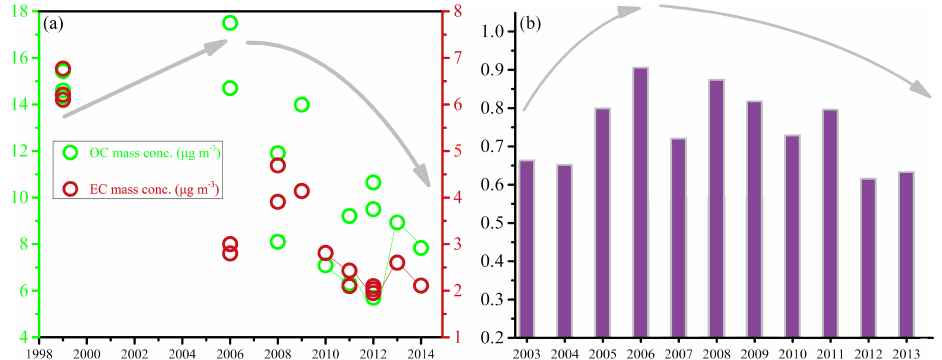
Figure 5. Long-term evolution of annual carbonaceous aerosol concentrations (a) and MODIS-derived aerosol optical depth (b) in Shanghai. Note that the line-collected circles in the left figure represent the results in this study; the sources of the rest circles are listed in Table S1.